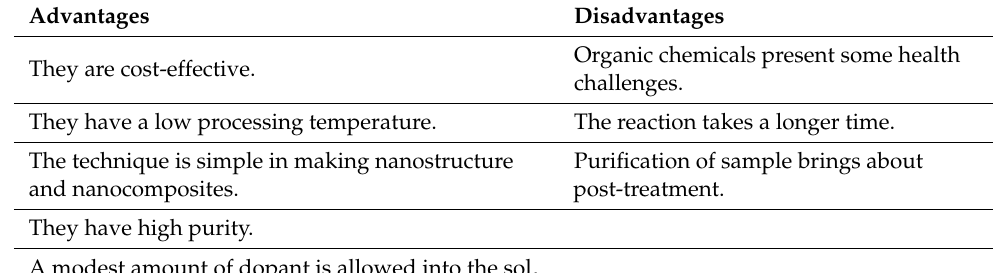
Table 3. Advantages and disadvantages of sol-gel techniques.